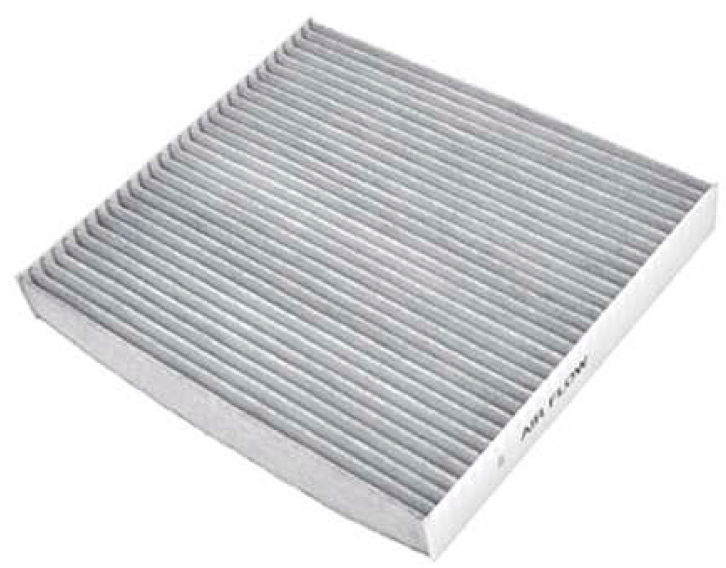
Figure 6. Direct type air conditioning filter. Table 1. Dimension of the vortex tube.